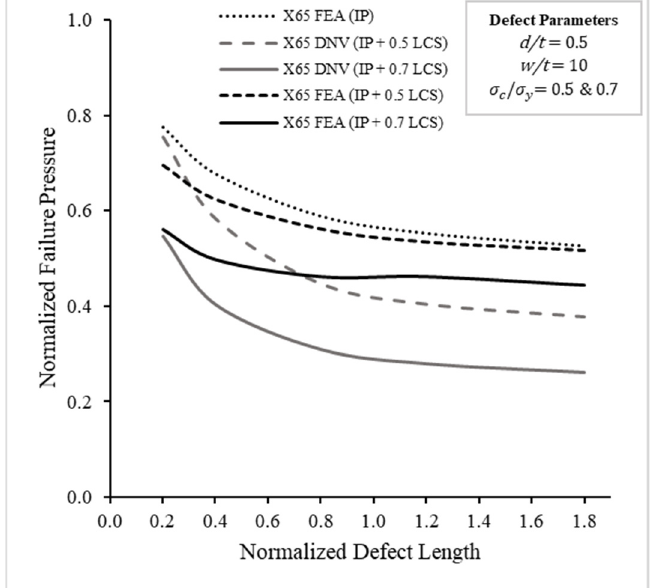
Figure 11 . FEA and DNV predictions of normalized failure pressure predictions versus normalized defect length with 0.5 and 0.8 normalized longitudinal compressive stress.